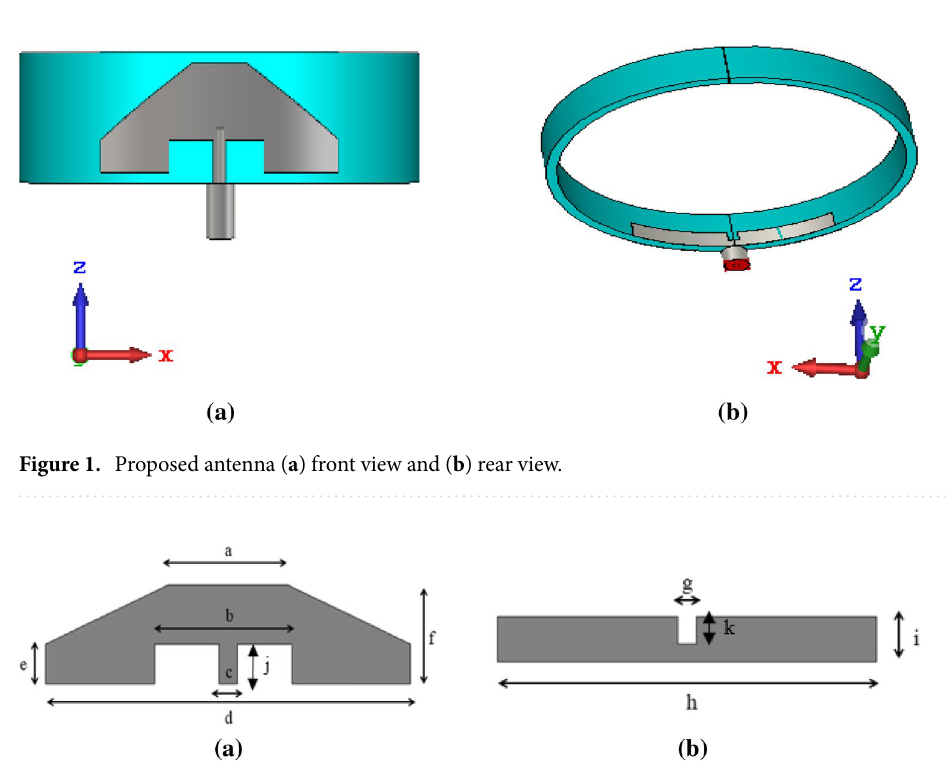
Figure 2. Dimensions of the wristband antenna ( a ) radiator ( b ) ground plane ( a = 13 mm, b = 15 mm, c = 2 mm, d =4 0 mm, e = 4 mm, f = 12 mm, g = 2 mm, h = 40 mm, i = 5 mm, j = 4 mm, k = 3